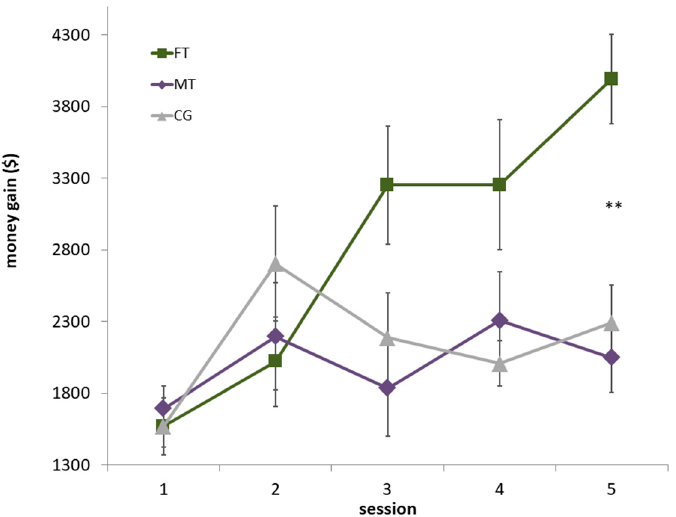
Figure 3. Influence of Filter Training (FT), Memory Training (MT) on IGT outcome compared to a passive Control Group (CG) displayed as means and standard errors; ** p < 0.001 for post-hoc comparison (Bonferroni corrected).